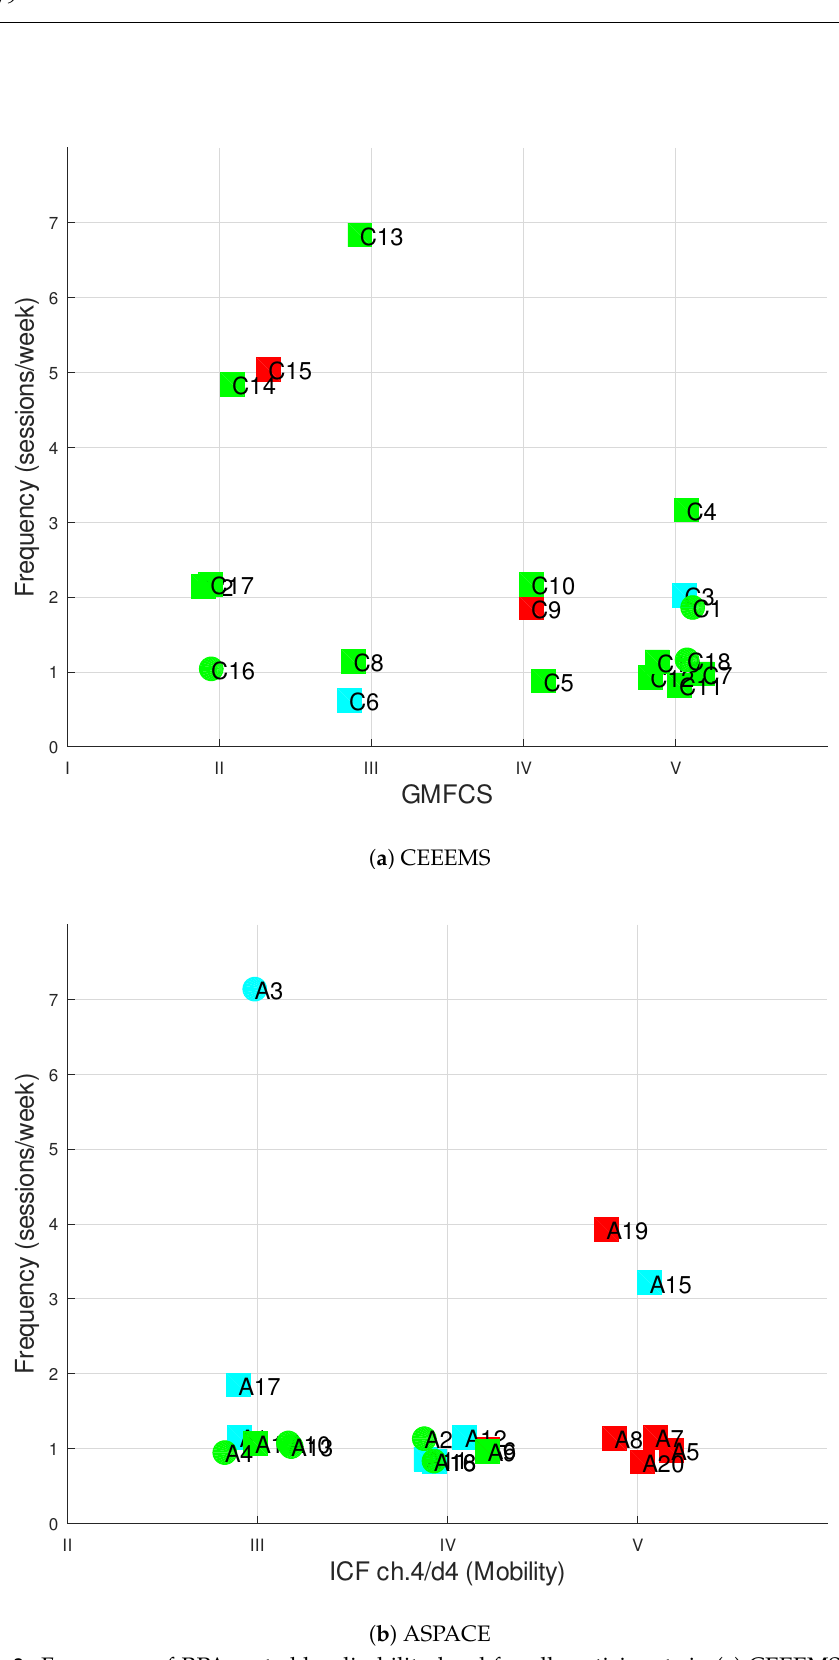
Figure 3. Frequency of RPA sorted by disability level for all participants in ( a ) CEEEMS and ( b ) ASPACE. The shape of the marker represents the type of activity: rehabilitation (squares) or rehabili- tation + personal choice (circles). The color also indicates the degree of acceptance of the activity: like it (green), neutral (blue), not like it